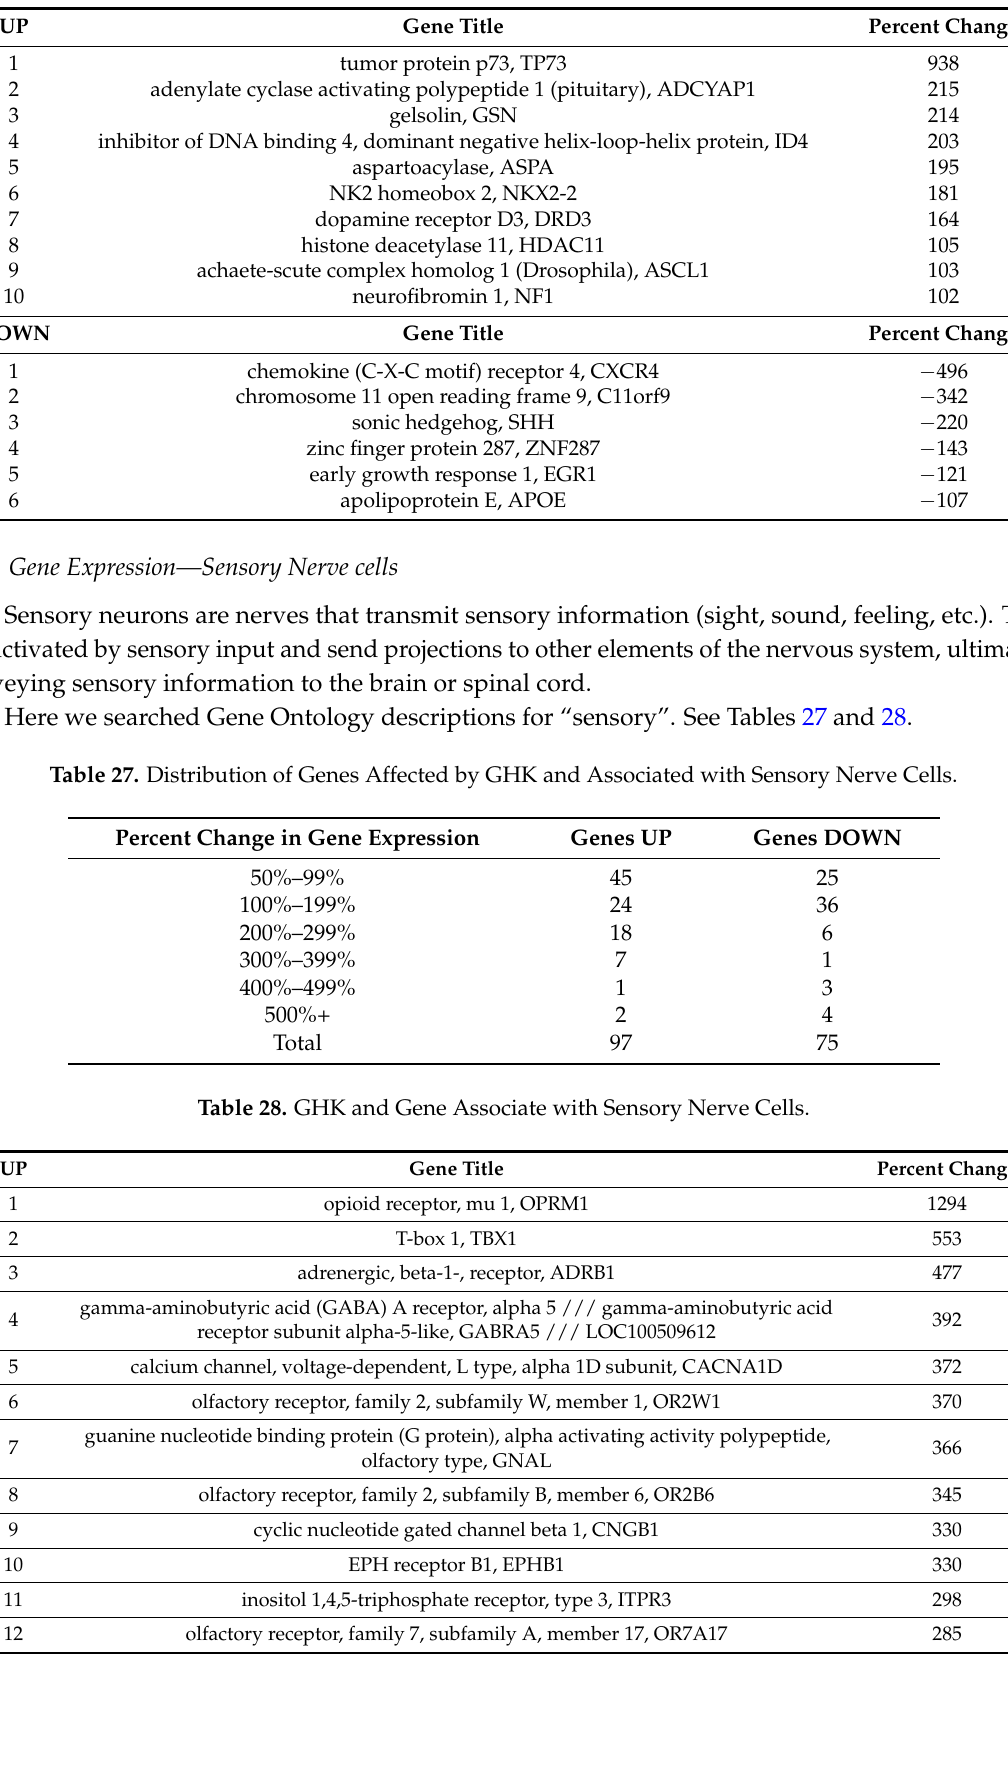
Table 26. GHK and Genes Associated with Oligodendrocytes.